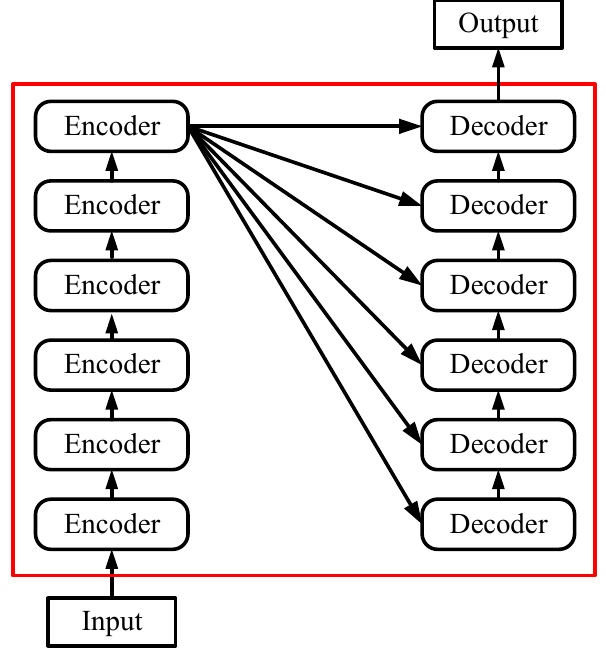
Figure 1. Structure of the used Transformer.